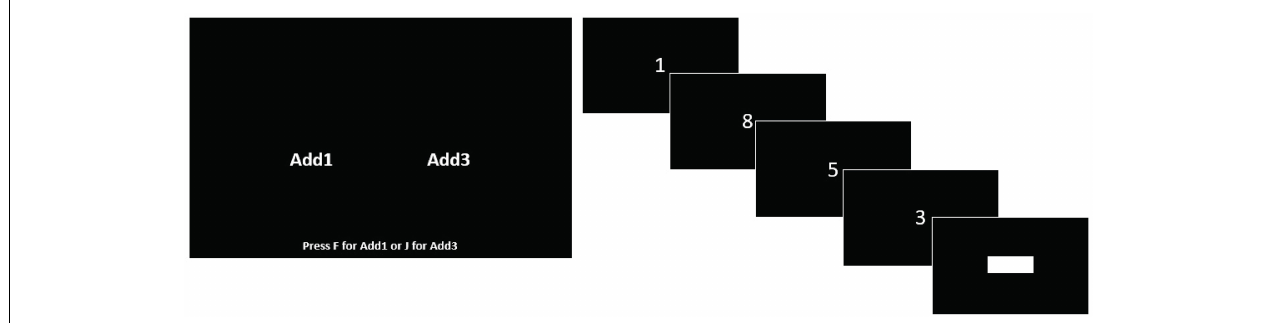
FIGURE 1 | Add1/add3 choice task used in Studies 1 and 2. Participants saw the choice screen, and once they made a selection, were presented with four numbers and a box to enter the response.